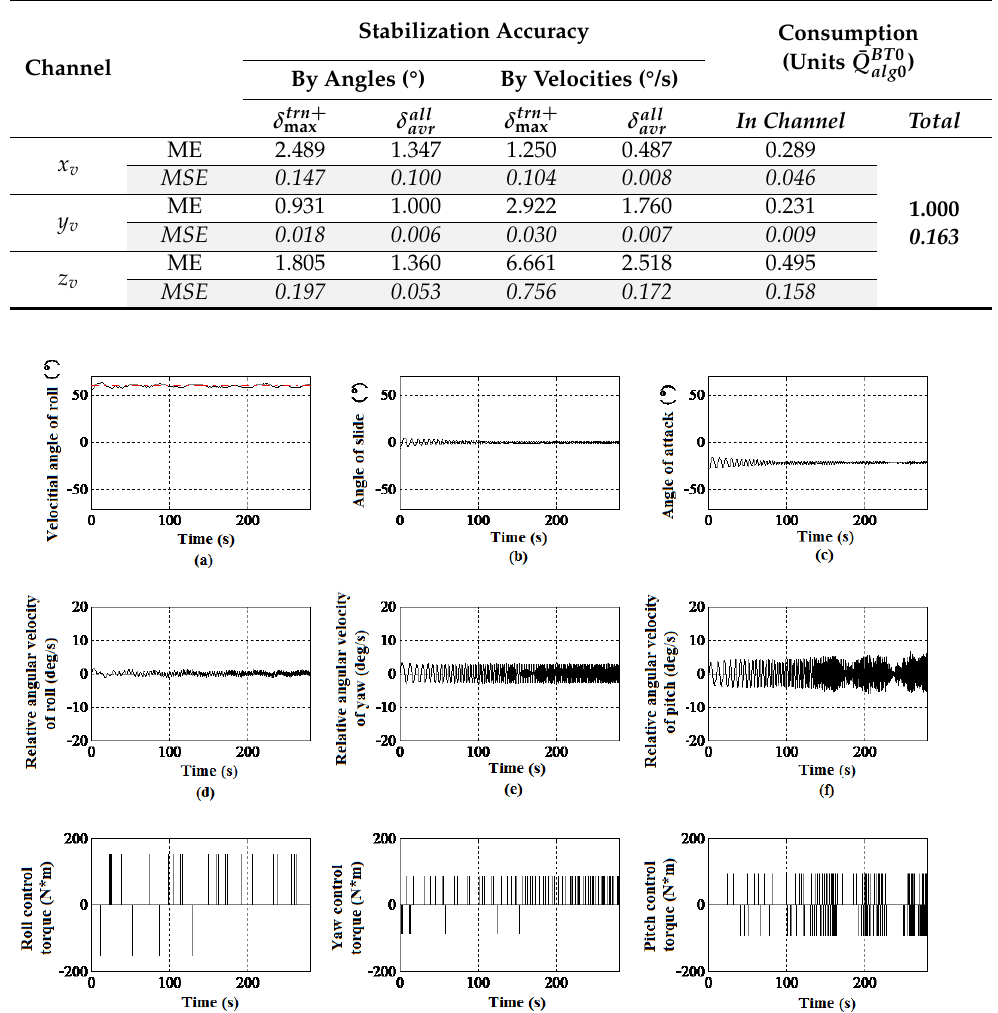
Table 4. Statistics of lander stabilization processes without roll overturns according to the standard algorithm.